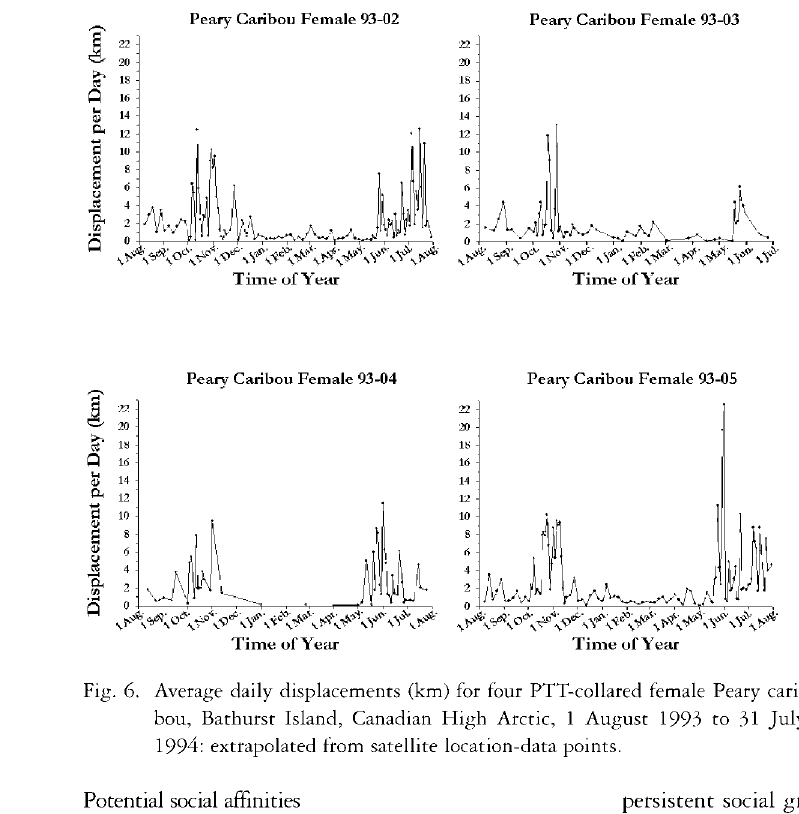
Fig. 6. Average daily displacements (km) for four PTT-collared female Peary cari bou, Bathurst Island, Canadian High Arctic, 1 August 1993 to 31 July 1994: extrapolated from satellite location-data points.